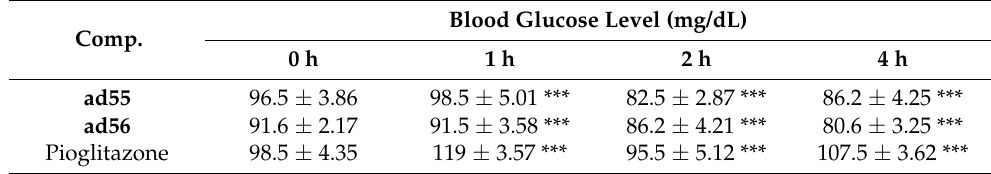
Table 53. Antidiabetic potential of the compounds ( ad55 – ad56 ) using a sucrose-loaded model in rats. Comp.